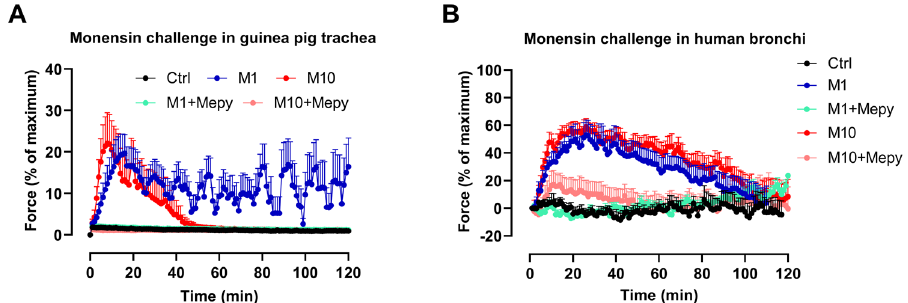
Figure 3. Responses of guinea pig trachea and human bronchi to monensin. ( A ) Smooth muscle contraction of tracheal segments and ( B ) human bronchi to 1 µM (M1) or 10 µM (M10) monensin with or without the presence of mepyramine (1 µM; Mepy) (n = 5–6 per group).